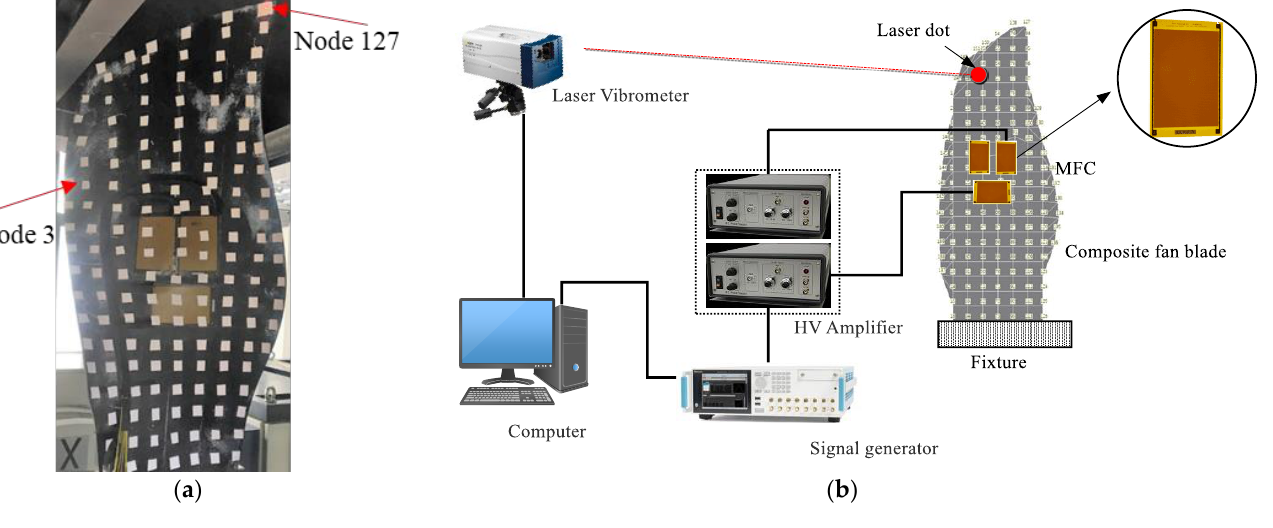
Figure 2. Schematics of the vibration test system: ( a ) Photo of the fan blade with 3 MFC actuators; ( b ) Test system.